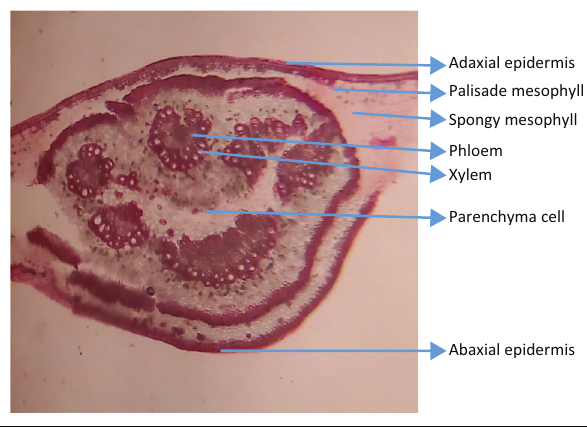
FIGURE 2: Transverse section of Isoberlinia doka with magnification × 40. TABLE 5: Quality and quantity of DNA sample from Isoberlinia doka and Isoberlinia tomentosa .